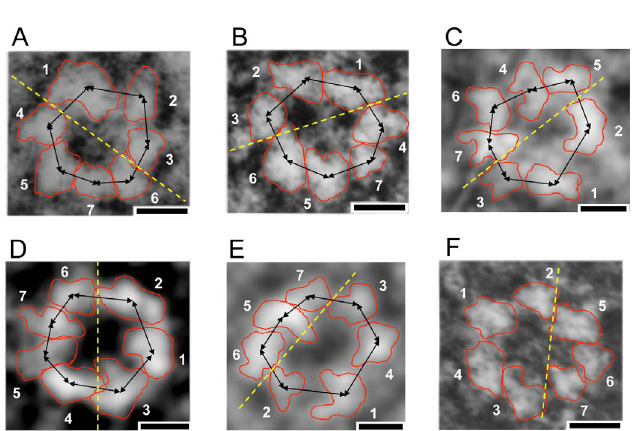
Fig. 5 Representative TEM images of the Hlg pore fitting the HP patterns TEM images fitting the HP on the basis of S1 and S7 were selected from high-resolution negative images of 60 pores. Panel A-C and D-E are on the basis of S1 and S7, respectively. All of them have a polarized arrangement, and the dashed lines in the figures mean partitioning between the groups of Dc1-Dc3 (or Dc1-Dc4) and Dc4-Dc7 (or Dc5-Dc7). Panel A, B, C and E correspond to the LHP. The scale bars mean 3